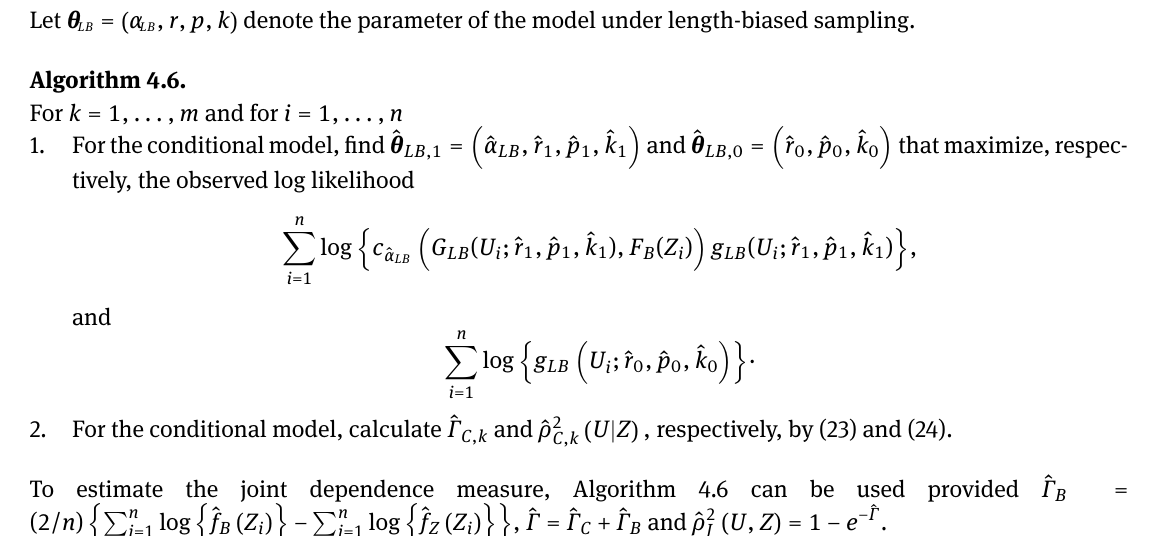
and H , using 1 0